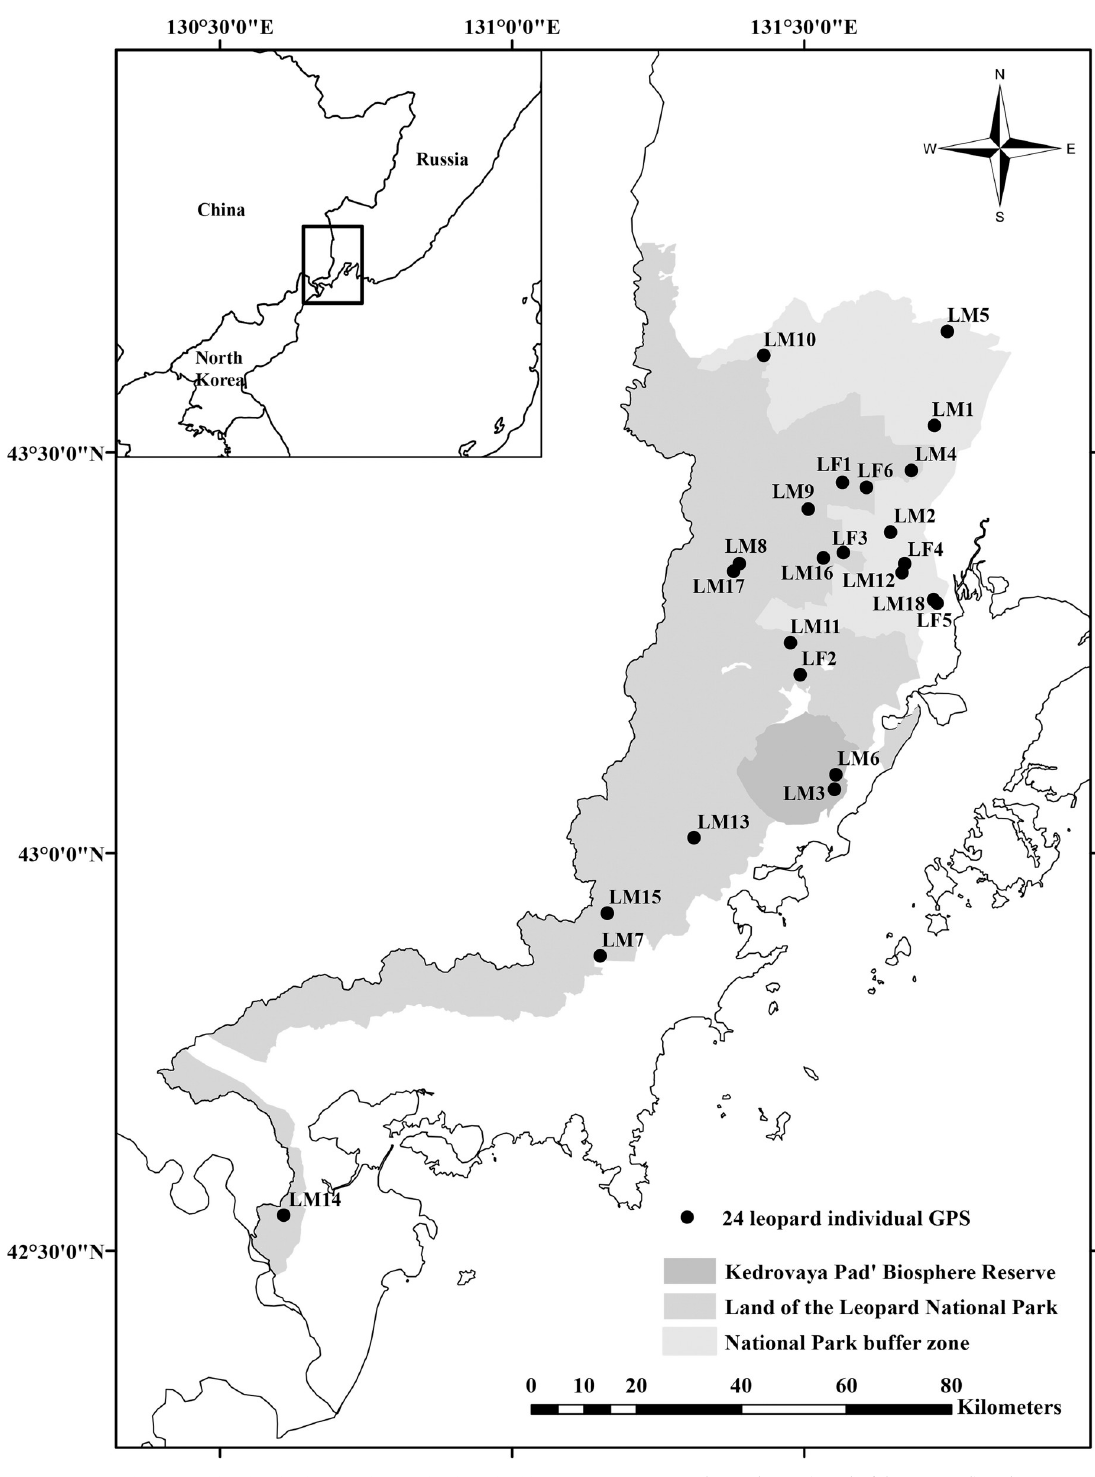
Fig 1. Capture location of individual Amur leopards identified by a genetic survey. The study site (Land of the Leopard) is shown in gray. The representative sample GPS locations of 24 individuals are depicted as black dots.